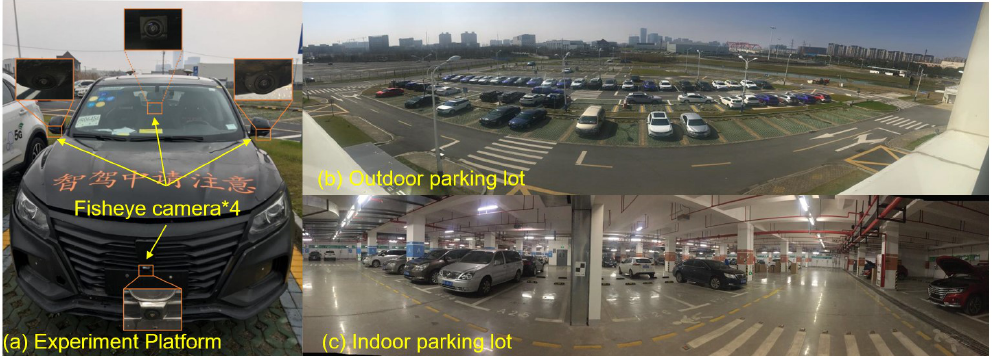
Figure 5. ( a ) The experimental platform with four fisheye cameras. ( b ) The outdoor and ( c ) indoor parking scenes.